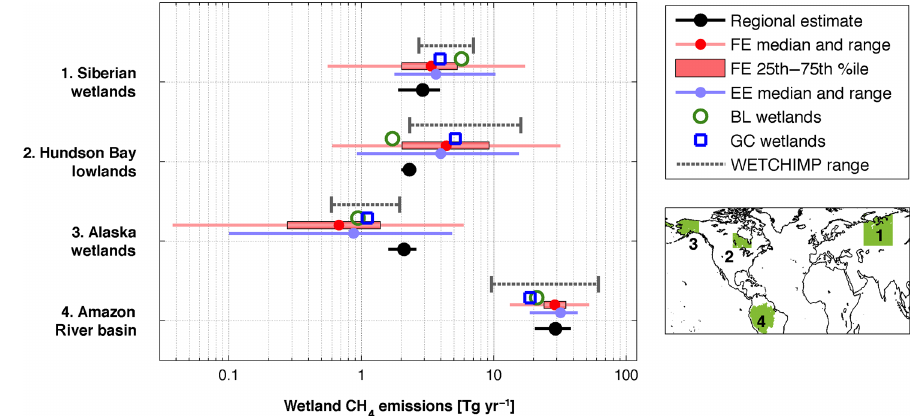
Figure 4. A comparison between the mean annual regional wetland CH 4 emission estimates of (1) Glagolev et al. (2011), (2) Pickett-Heaps et al. (2011), (3) Chang et al. (2014) and (4) Melack et al. (2004) and the global wetland emission datasets by Bloom et al. (2012) (BL), the GEOS-Chem wetland CH 4 emissions inventory (GC), this study (full ensemble: FE; extended ensemble: EE) and the range of WETCHIMP models (Melton et al., 2013). Wetland emissions (horizontal axis) correspond to the mean annual totals within the regions shown in the inset map.